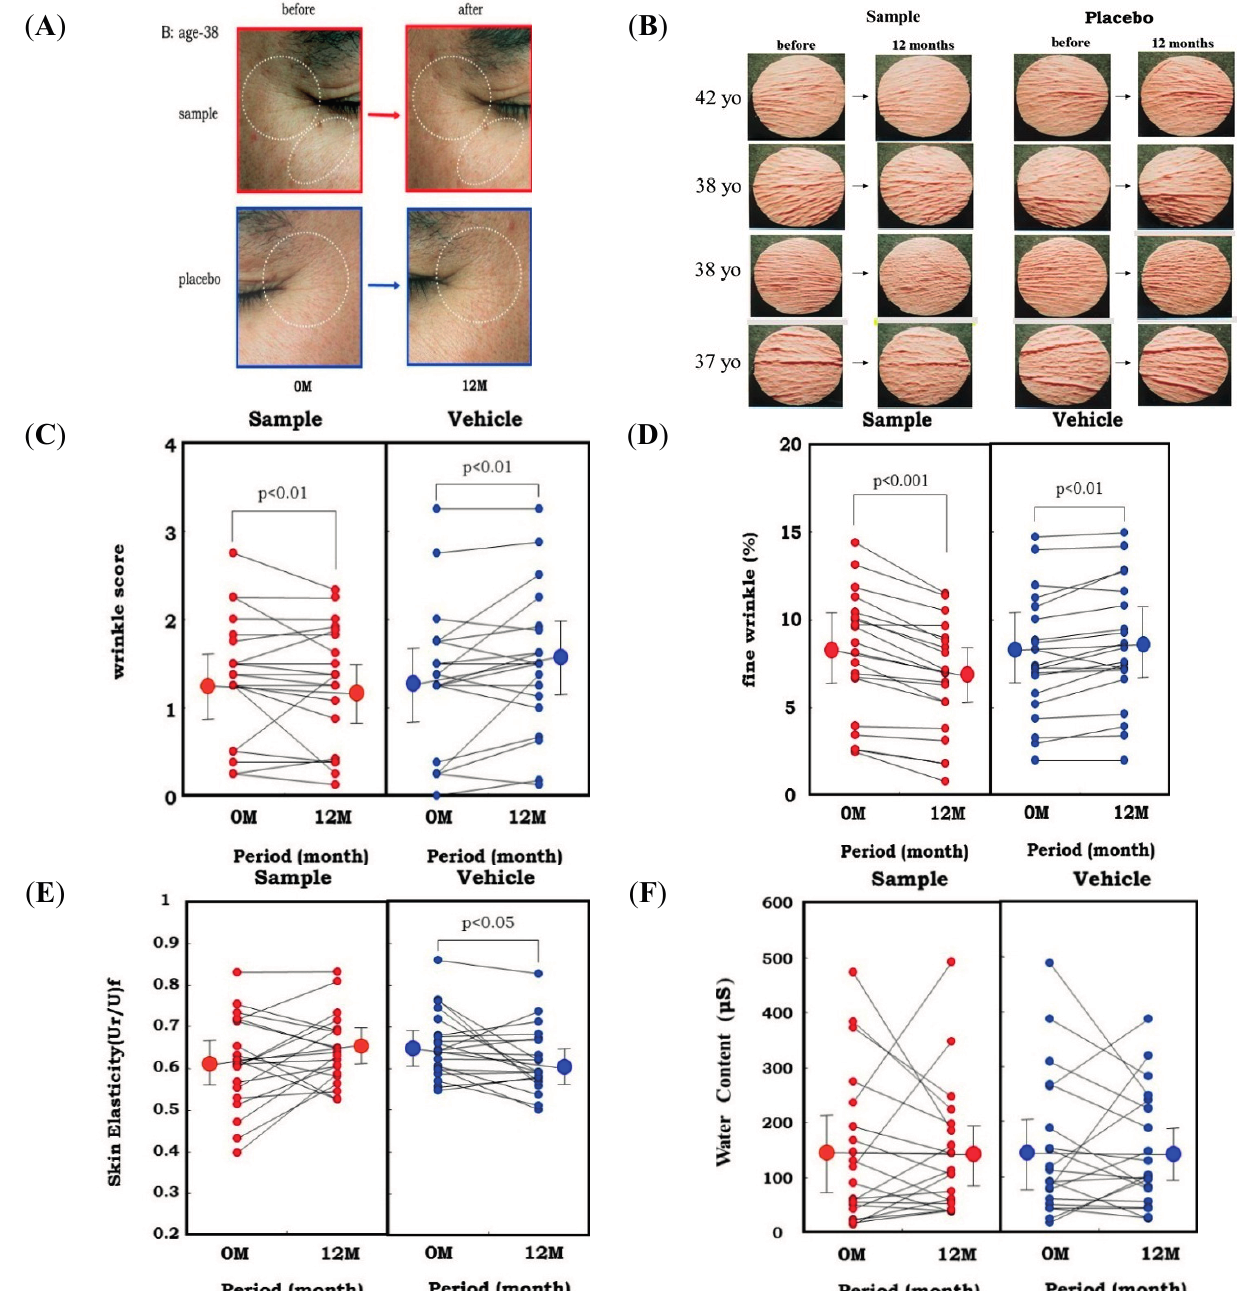
Figure 12. Clinical study using a skin fibroblast inhibitory extract on wrinkling of human facial skin. ( A ) Representative photos of the corners of the eyes before and 1 year after topical treatment with the Zingiber officinale (L.) Rose extract; ( B ) Replicas; ( C ) Wrinkle score; ( D ) Fine Wrinkle percent evaluated by image analysis; ( E ) Skin elasticity; ( F ) Water